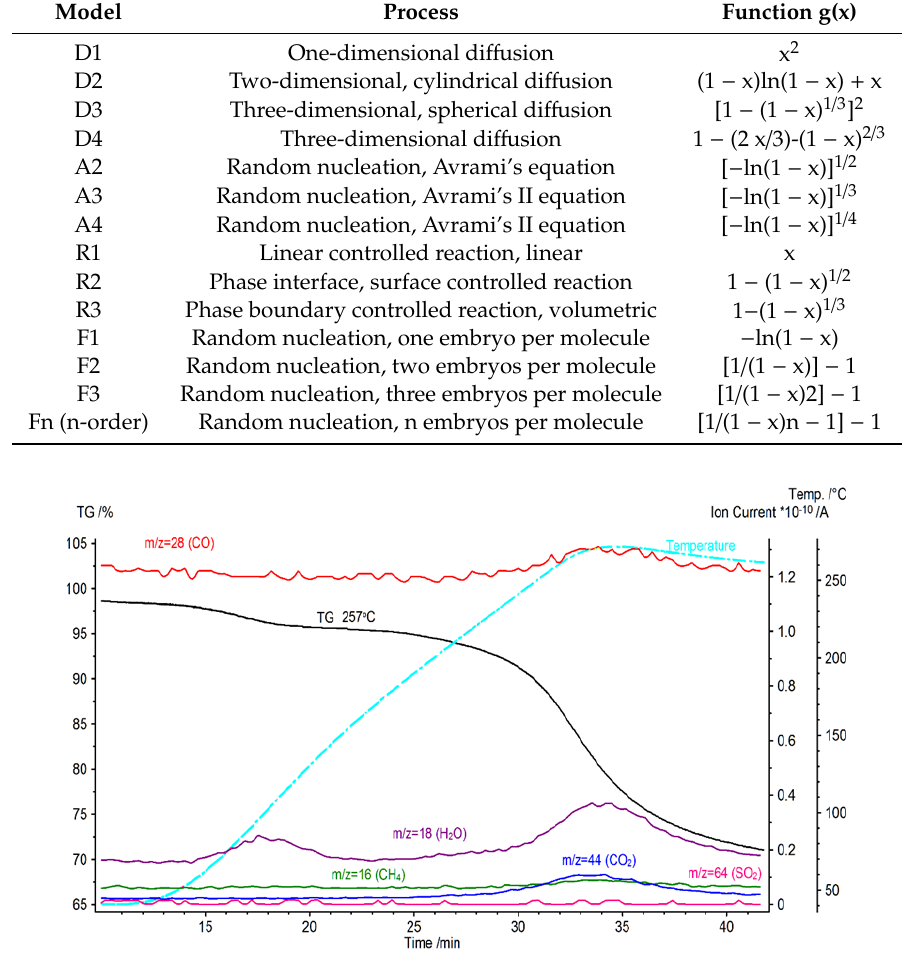
Figure A9. TG curve and ion current curves for the oat straw torrefaction process carried out up to 257.5 °C.